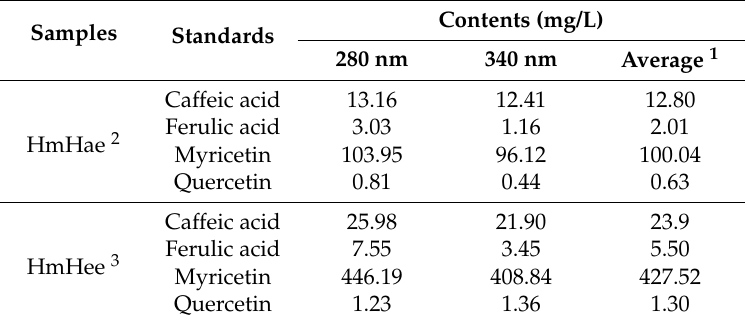
Table 1. Quantified HPLC analysis of polyphenolic compounds from HmHae and HmHee. Samples Standards